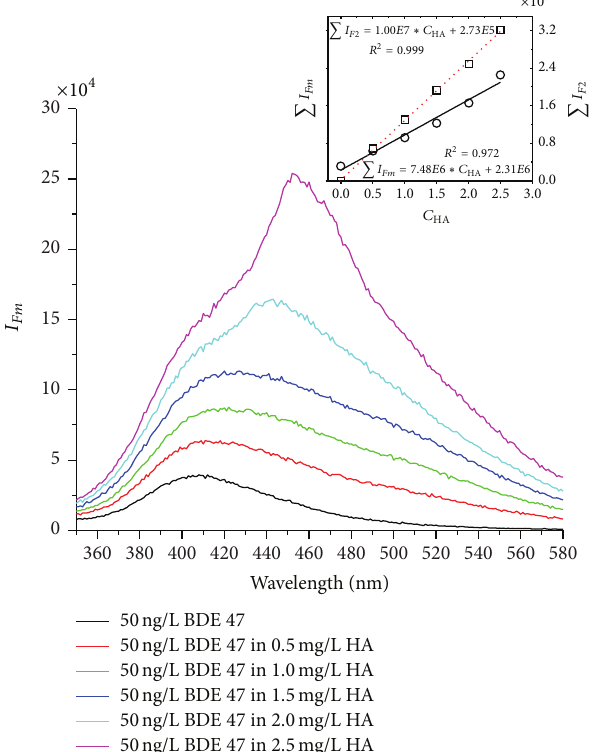
Figure 5: Fluorescence spectra of solutions containing mixed BDE 47 and HA. The figure inserts show the linear correlations of fluore- scence intensity as a function HA concentration in solutions with and without BDE